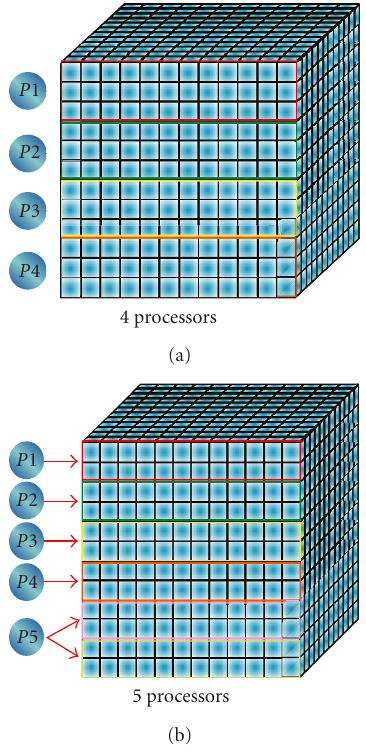
Figure 3: Spatial-domain decomposition of a hyperspectral data set into four (a) and five (b)